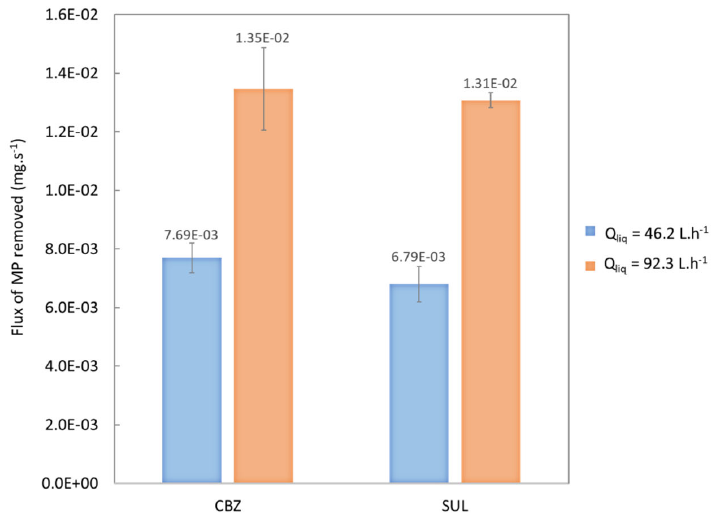
Figure 7. Flux of CBZ and SUL removed at a liquid flow ‐ rate of 46.2 L.h − 1 and 92.3 L.h − 1 , an ozone concentration at the gas ‐ phase inlet of 15 g.Nm − 3 and a gas flow ‐ rate of 8 L.h − 1 at neutral